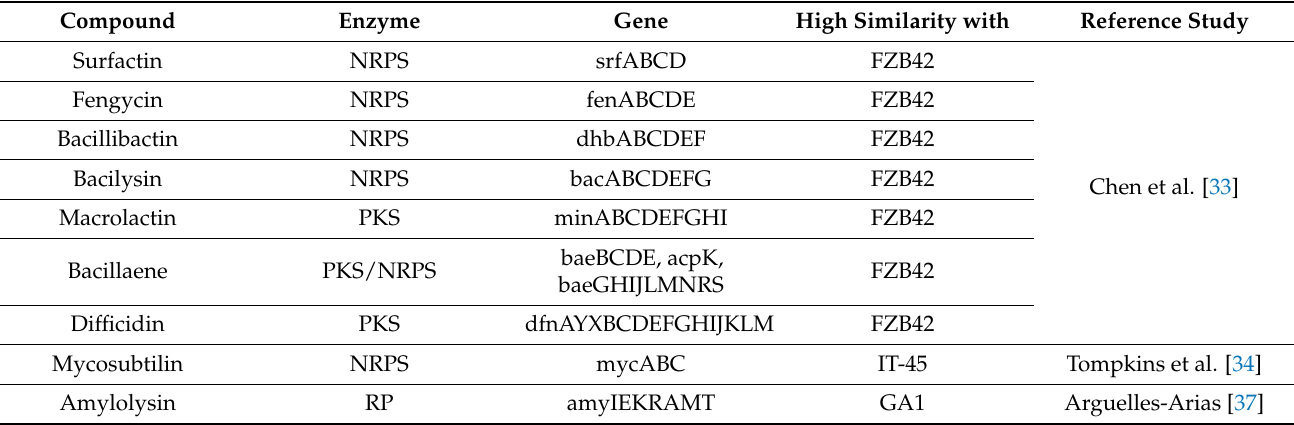
Table 2. Gene clusters involved in synthesis of secondary metabolites in B. velezensis strain B25. NRPS: nonribosomal peptide, PKS: polyketide synthase, RP: ribosomal peptide.